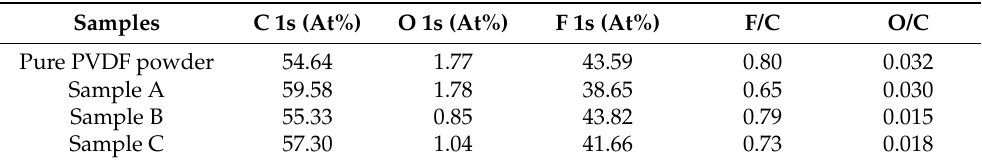
Table 1. The elemental compositions (in atomic percentage) of the pristine PVDF powder and the as-prepared fiber samples.